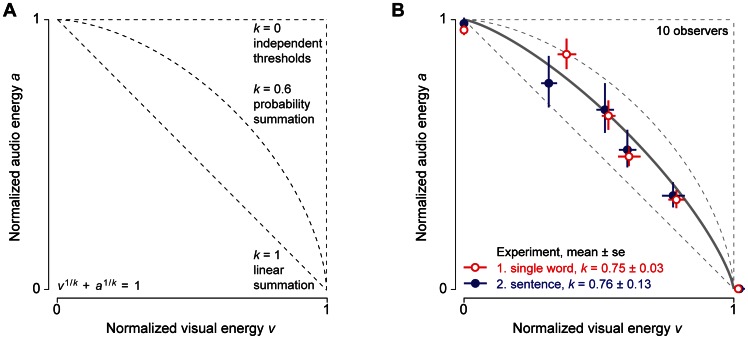
Predictions and Results.(A) Audio-visual summation is summarized by the summation index k of a smooth curve (Eq. 8) fitted to the threshold energies. The horizontal and vertical scales represent the normalized visual and audio energy components v = V/V
uni and a = A/A
uni of the bimodal signal at threshold. Each audio:visual ratio – including the two unimodal conditions (V
uni, 0) and (0, A
uni) – is a condition. All conditions are randomly interleaved, trial by trial (with one exception, described at the end of this caption). The noise is always present in both streams. For a given audio:visual ratio A/V, we measure the threshold (V, A) radially, along a line from the origin (0, 0). The curves represent degrees of summation ranging from none (k = 0) to complete (k = 1). The special case of k = 0 is to be understood as the limit as k approaches 0, which is max(v,a) = 1. (B) Averaging k over our ten observers, we find the same summation for reporting either a single word (k = 0.75, red, Experiment 1) or a sentence (k = 0.76, blue, Experiment 2). The error bars indicate mean ± standard error. The curves obtained for each individual observer are shown in Figure S2. The virtue of randomly interleaving conditions (a:v ratios) is that the observer begins every trial in the same state, which enhances the comparability of the conditions plotted above. However, one might wonder how much better the observer would perform when the whole block is devoted to one condition. Random interleaving produces uncertainty; blocking each condition does not. Testing one observer (MD) on three conditions (audio, visual, and audiovisual signal; noise always present in both streams) we find insignificant difference in thresholds measured with and without uncertainty (i.e. interleaved vs. blocked conditions). Furthermore, ideal observer thresholds for the same conditions are negligibly different with and without uncertainty. This indicates that the results presented in this figure, found with uncertainty, also apply to performance without uncertainty.